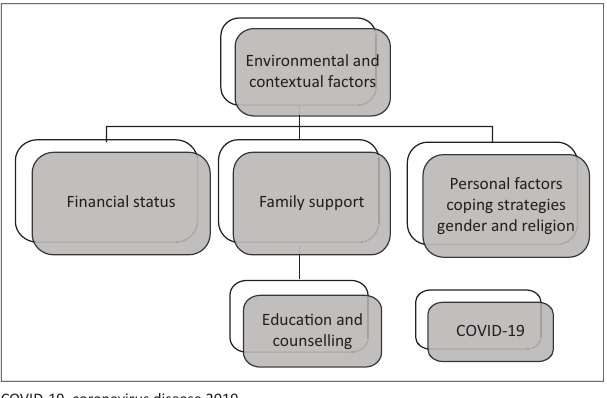
FIGURE 3: Sub-themes under environmental and contextual